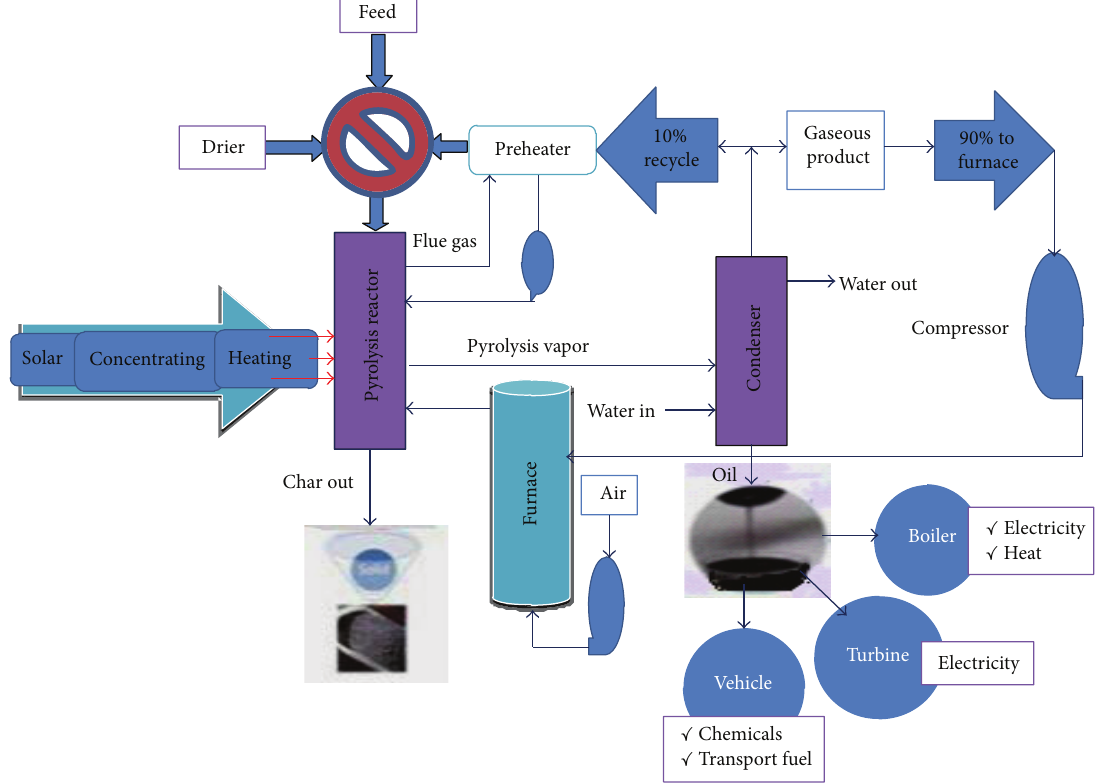
Figure 2: Conceptual solar fast pyrolysis system for commercial